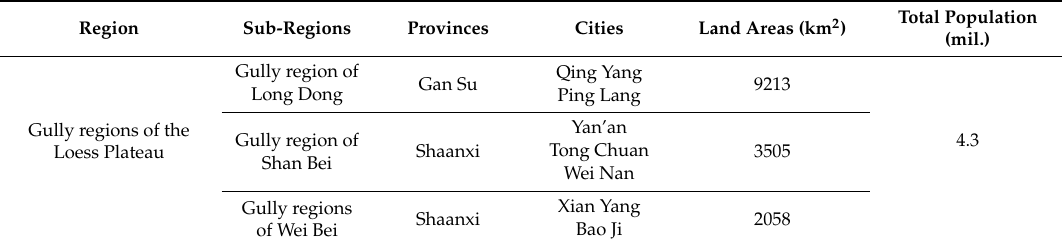
Figure 1. Location of gully regions. Table 1. Space distribution in gully regions of the Loess Plateau.